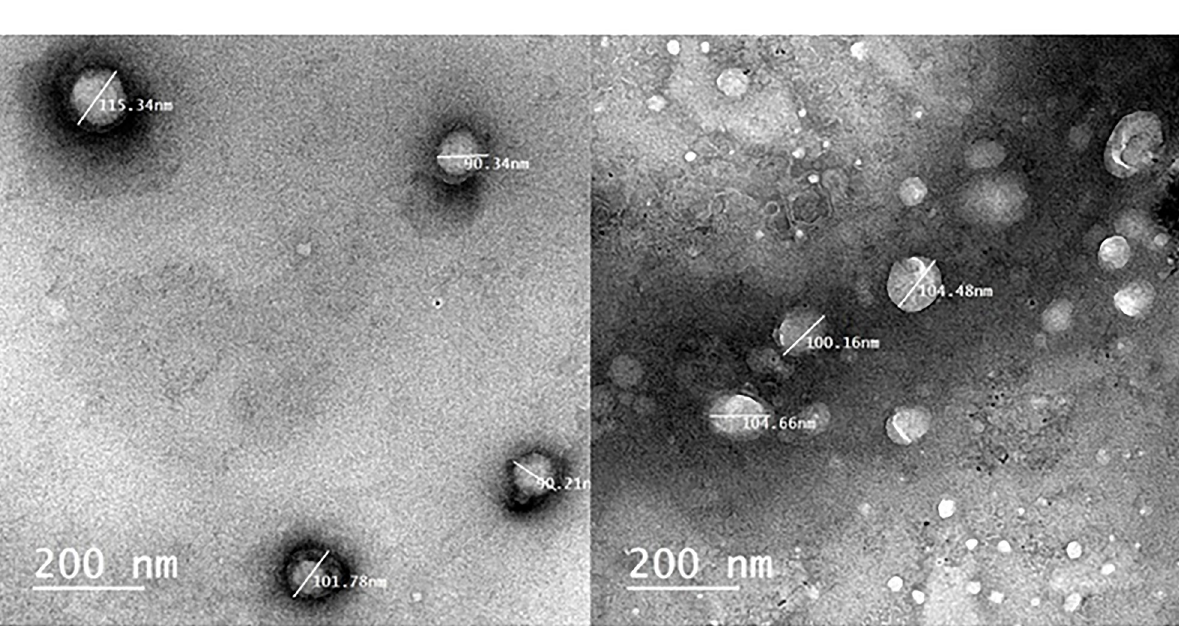
PLOS ONE | https://doi.org/10.1371/journal.pone.0269864 October 6,